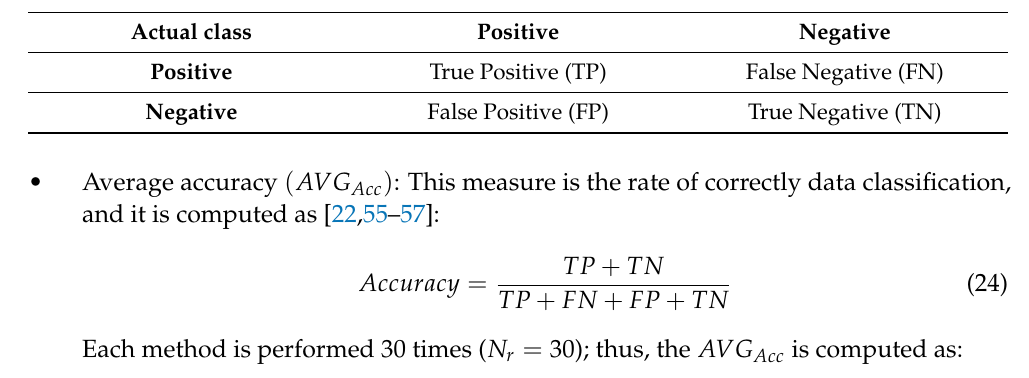
(HGS) algorithm (HGSO), Whale optimization algorithm (WOA), grey wolf optimization